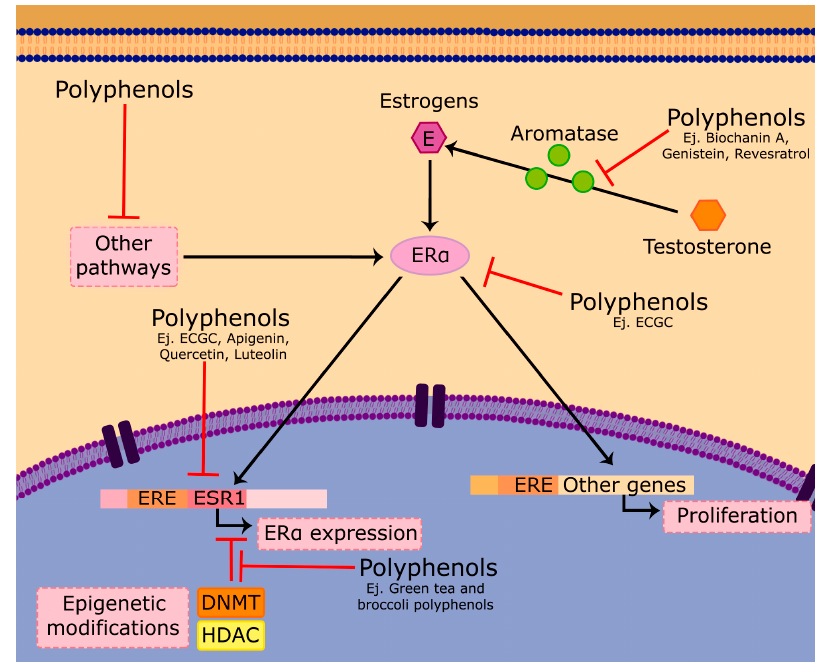
Figure 2. Estrogenic response can be modulated by polyphenol activity. ER activation leads to cell proliferation by activating estrogen response element (ERE)-controlled genes, including their own ER gene (ESR1). Some polyphenols are able both to inhibit ER activity (antiestrogenic action) or ER expression and consequently reduce cell proliferation. The ER activity can also be regulated by some transactivation pathways including the Ras/Raf, PI3K/Akt, AMPK or PKC pathways; all of them can be also modified by polyphenols. ESR1 gene expression can be also regulated by epigenetic modifications through chromatin modifying enzymes such as DNMT (DNA methyltransferases) and HDAC (histone deacetylases). Finally, estrogen synthesis from androgens by aromatase can be also blocked by some polyphenols.